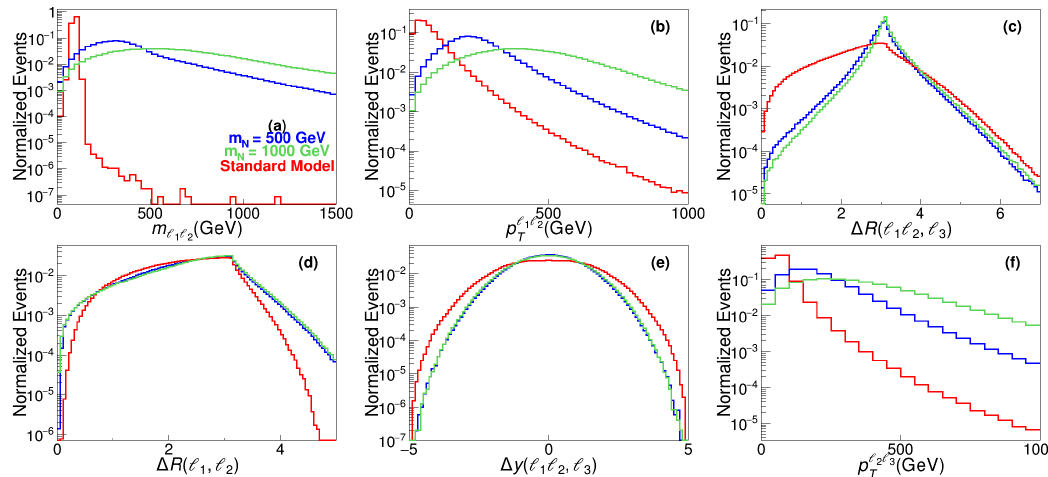
(upper left), p ‘ 1 ‘ 2 (upper middle), T 1 ‘ 2 ) (lower middle) and p ‘ 2 ‘ 3 (lower 1 ‘ 2 , ‘ 3 T = 500 GeV (blue) and 1000 GeV N